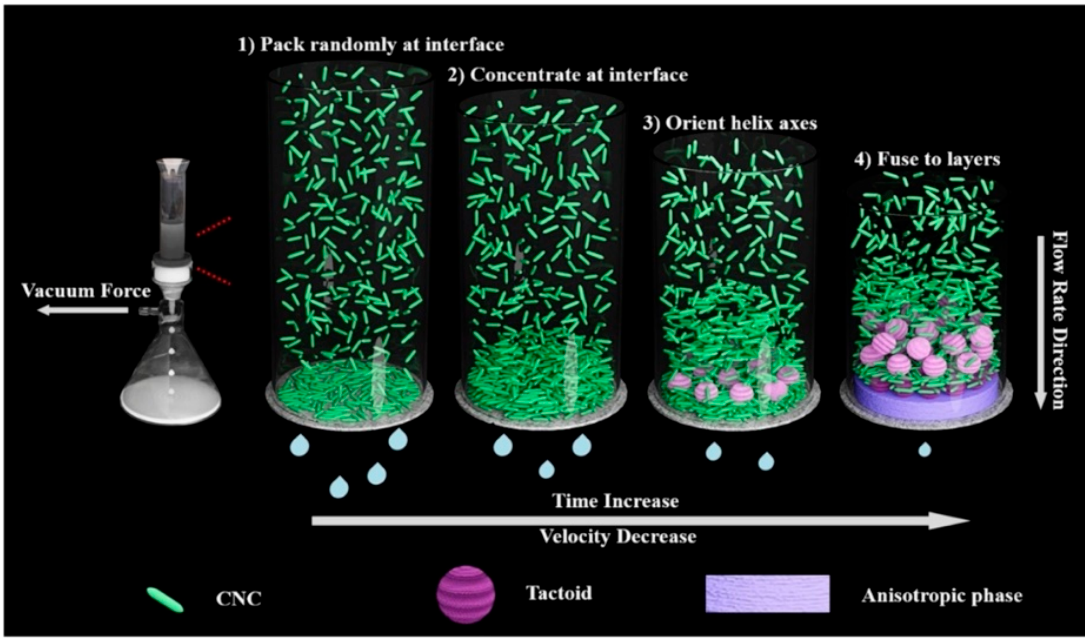
Figure 9. Schematic representation of the vacuum-assisted CNC self-assembly process. Reproduced from [82].